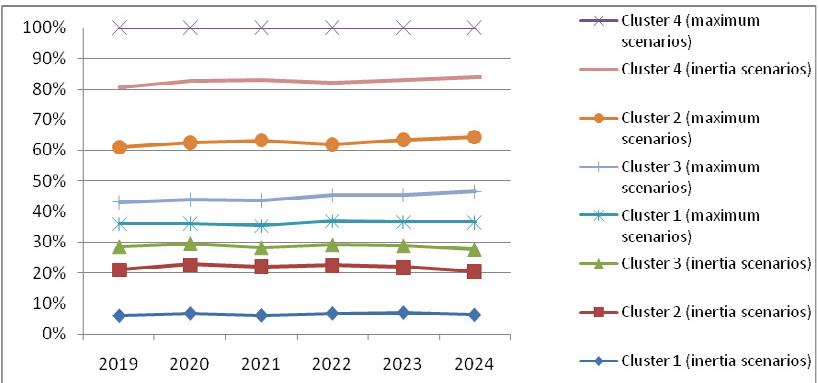
Fig. 9: Scenarios for rural development in Vinnytsia region